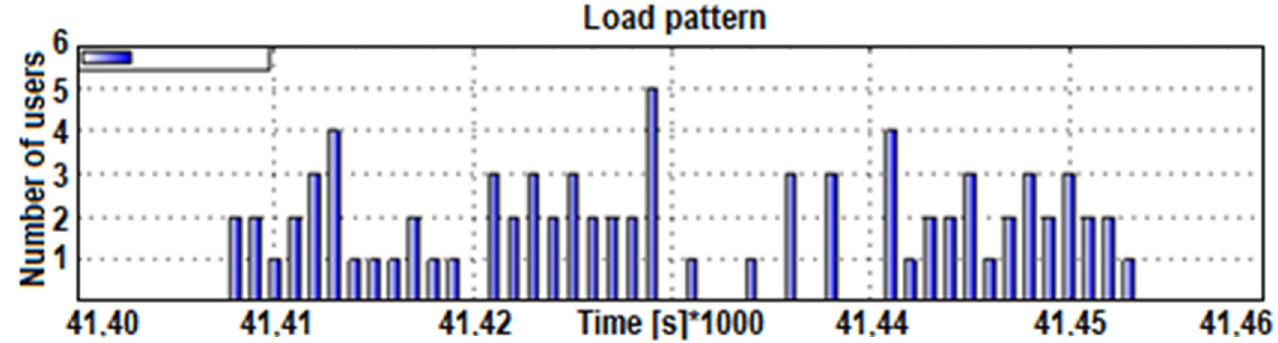
Figure 20. A generated load pattern for 81 charging service system users.